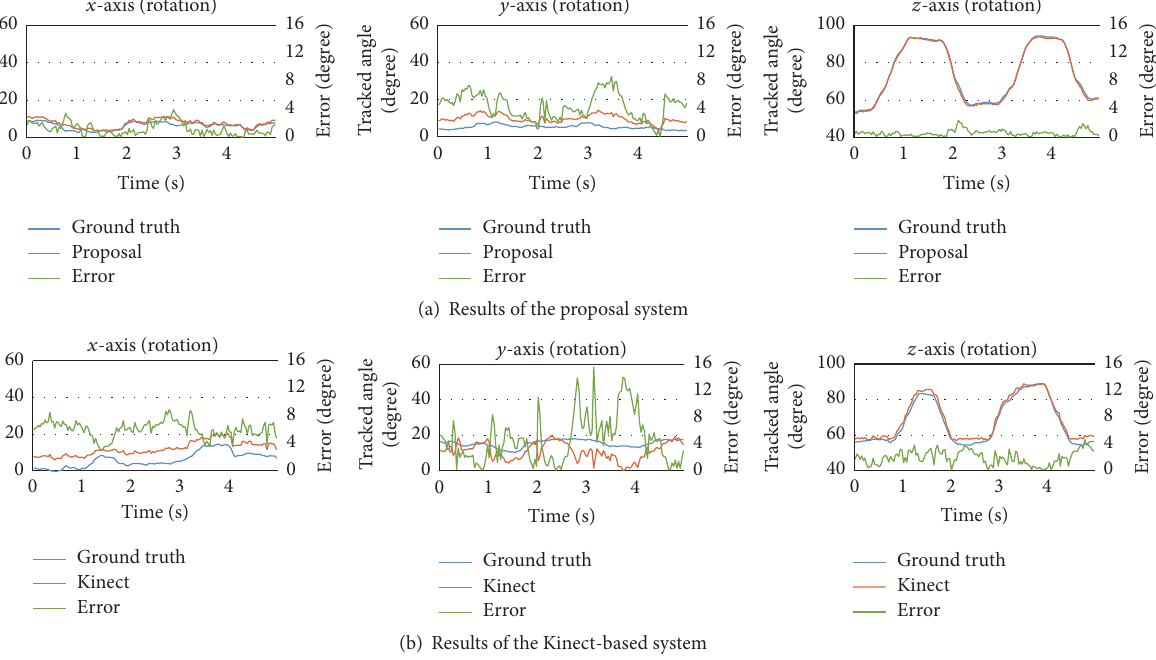
Figure 12: Tracked trajectories (rotation).